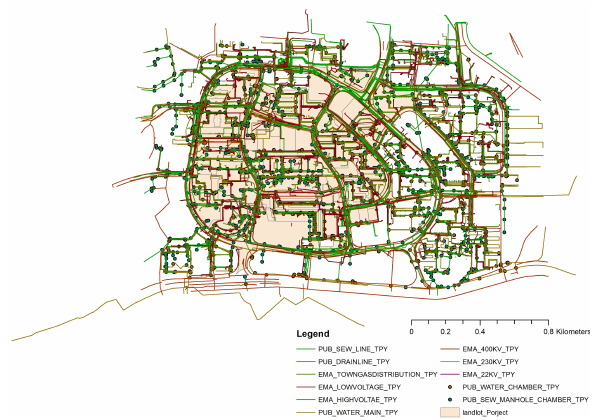
Figure 8. The existing utility and cadaster data of Toa Payoh (Data source: Singapore Land